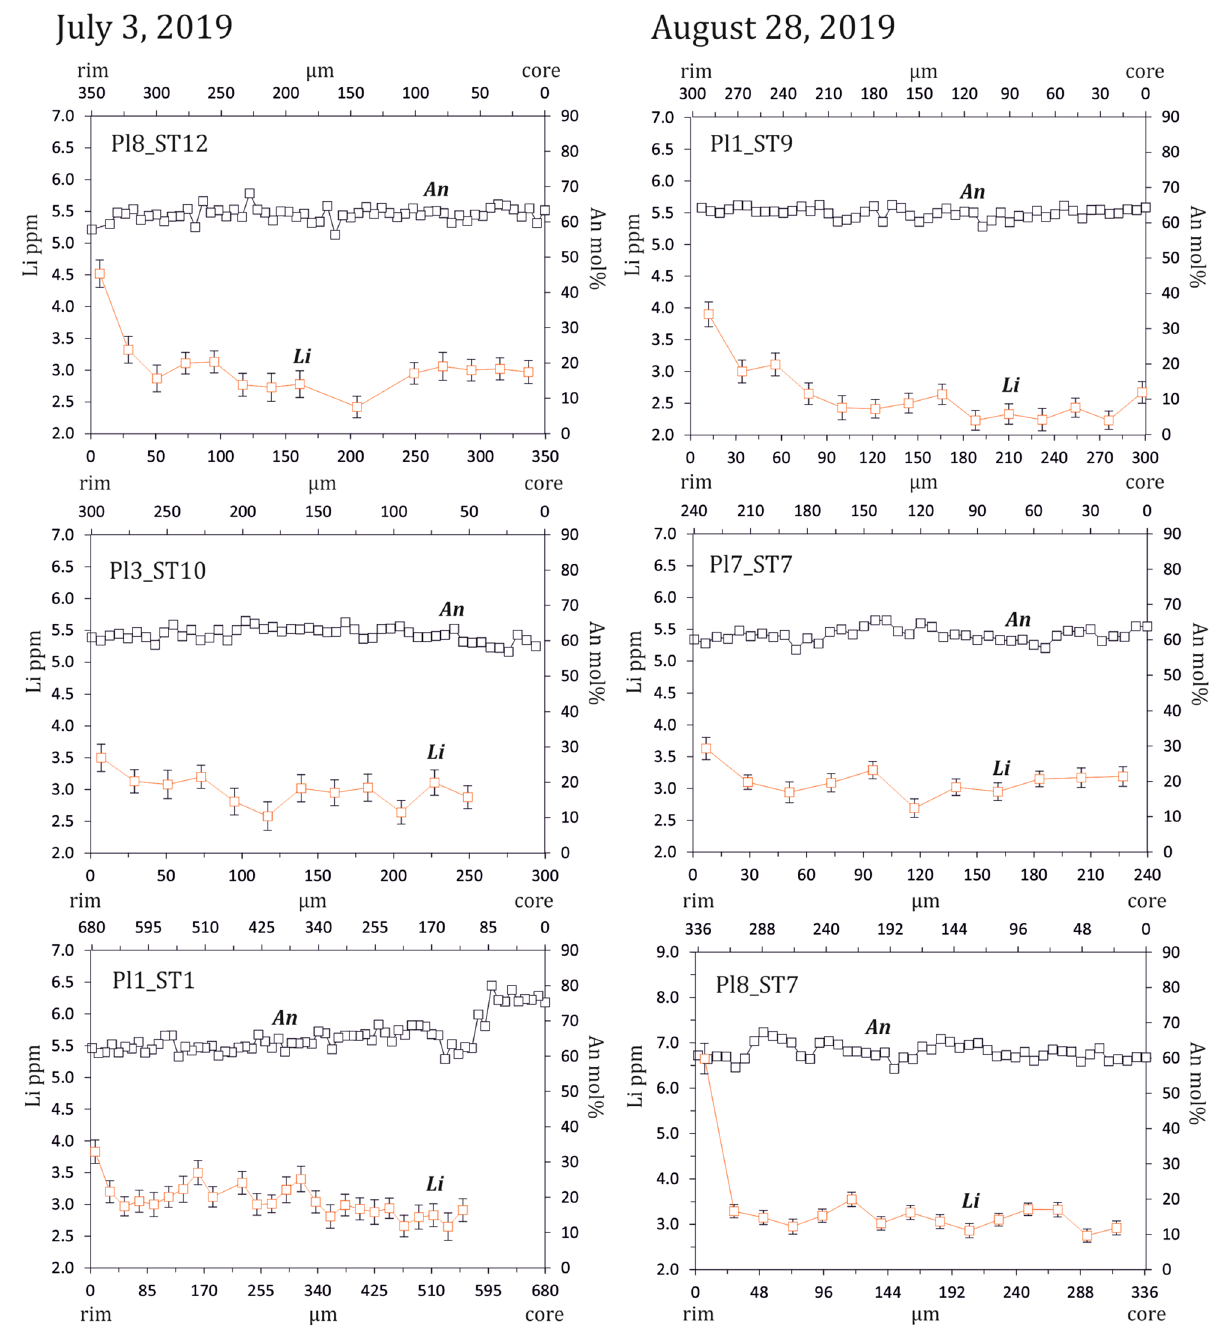
Figure 4. Compositional traverses for Li (ppm) and An (mol%) of representative plagioclase crystals. Error bars are the standard deviation of the mean of measurements (± 1σ). Error bars for the An content lie within the square symbol and are not